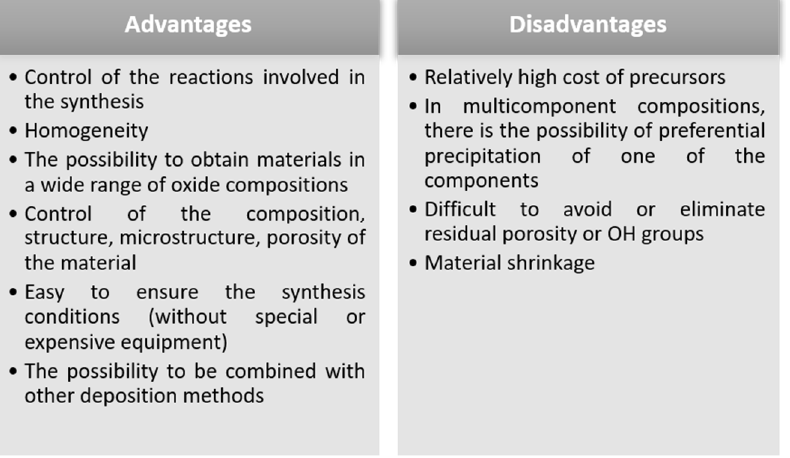
Figure 3. Advantages and disadvantages of sol-gel synthesis method.